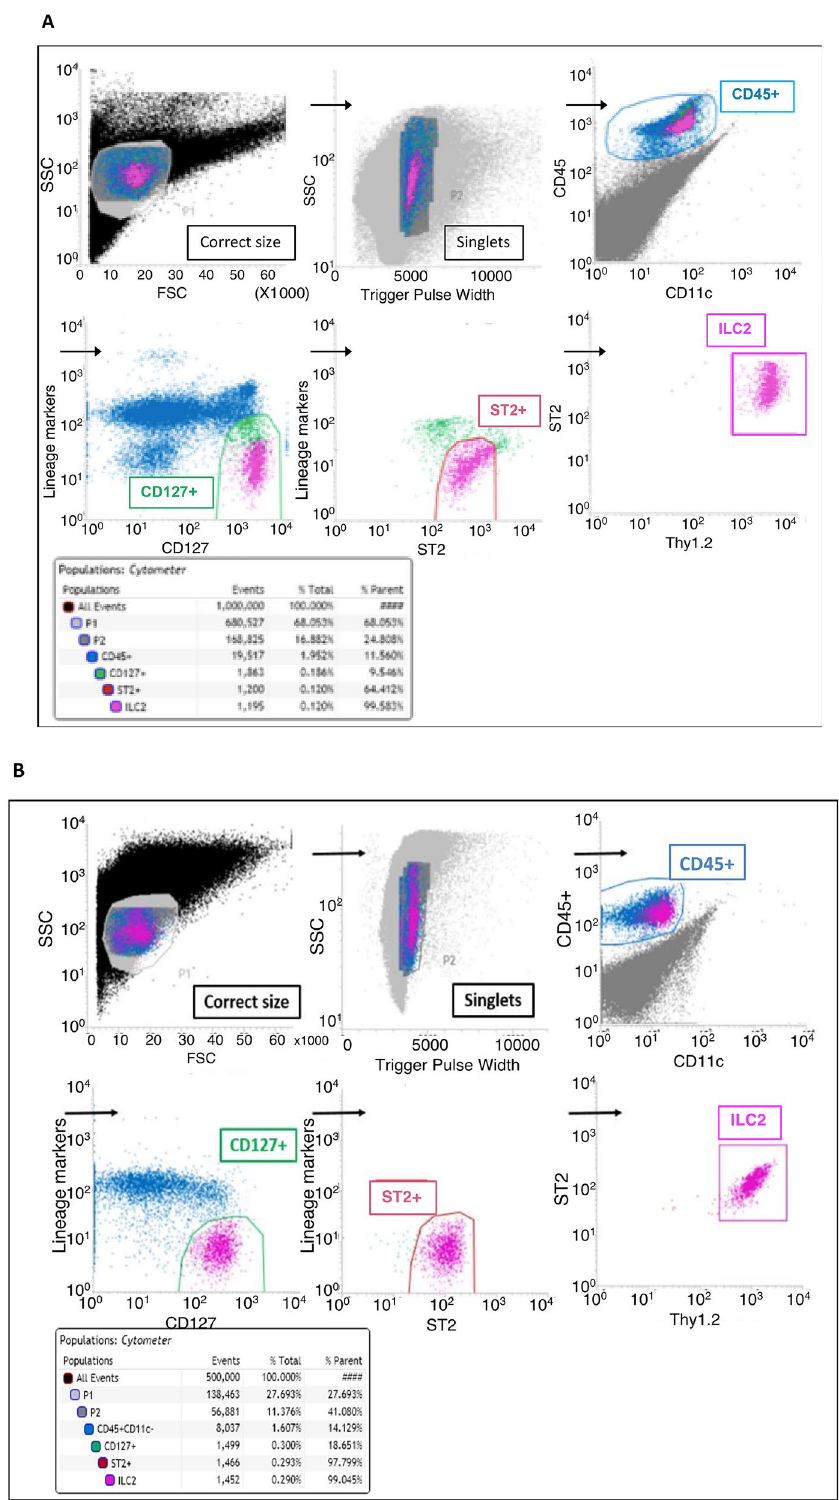
Figure 1. Gating strategy for ILC2s from lungs were sorted by FACS as Lin − ST2 + CD127 + CD90.2 + cells. ( A ) ILC2s isolated from untreated animals (0.1% of total). Sequential gating strategy was based on cell size [small and non-granular cells, forward scatter (FSC) versus side scatter (SSC)], depletion of doublets (FSC vs. Trigger Pulse Width), and selection of CD45 + cells. Cells with lineage-related markers were rigorously depleted during isolation process and the resultant cell numbers at each stage of purification is shown. ( B ) ILC2s isolated from IL-33-treated animals (0.3% of total). The final gate (double positive for ST2 and Thy1.2) includes ILC2s isolated and sorted from lung tissue. Purified Lin − ST2 + CD127 + CD90.2 + ILC2s express GATA3, IL5 and IL13 and this is stable during